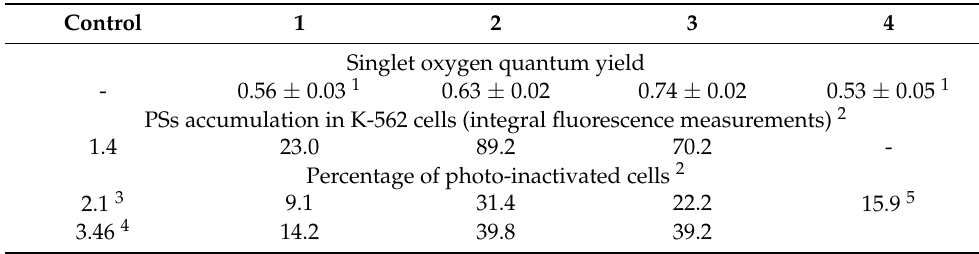
Table 3. Quantum yield of singlet oxygen 1 O 2 for comps. 1 – 4 in OctOH, PS accumulation in K-562 cancer cells and PS light toxicity